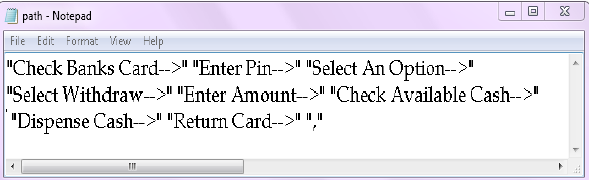
Fig. 14. Input transition guard to "Incorrect Pin" action Fig. 15. Path file for successful withdrawal track